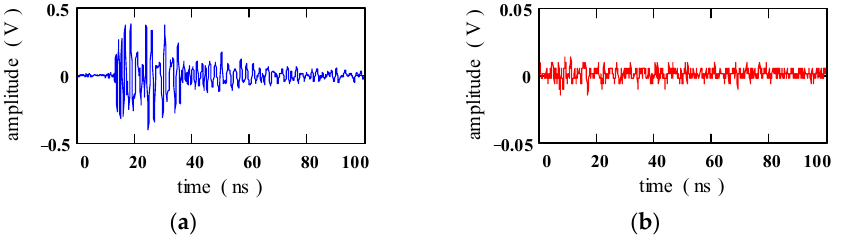
Figure 21. ( a ) A 100 ns portion of the UHF PD signal at S1 taken from Figure 20. ( b ) A portion of background signal selected from the same data.